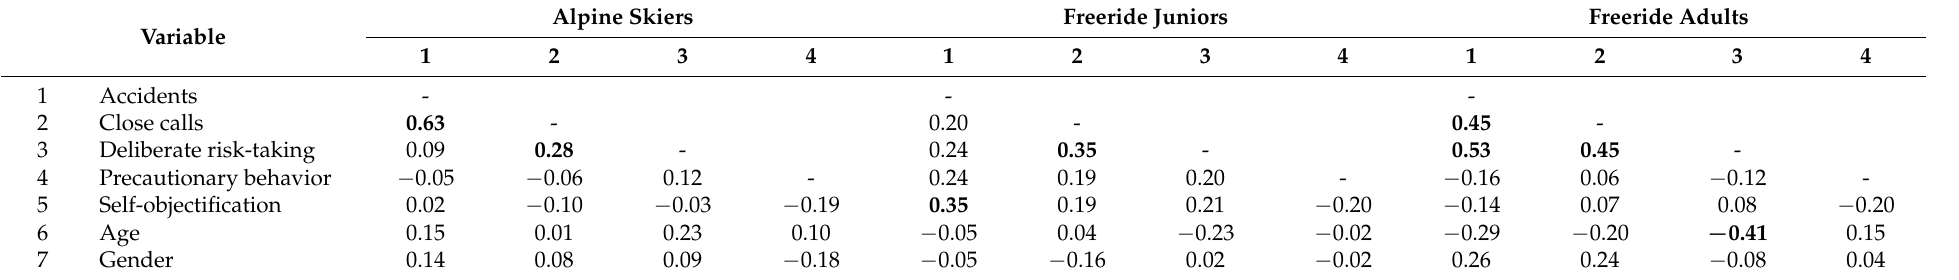
Table 2. Intercorrelations between risk-related variables, self-objectification and demographic aspects by group.